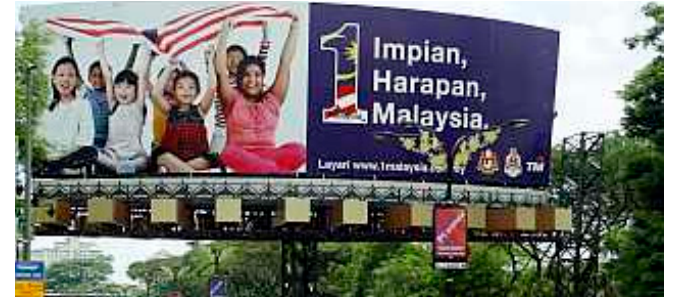
Figure 3. 1 Impian 1 Harapan 1 Malaysia billboard.